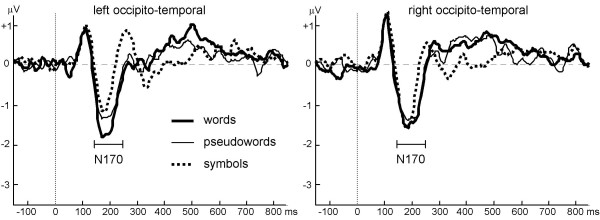
Waveforms at left and right inferior occipito-temporal channels. The N170 is larger for words than for pseudowords and symbols, especially at the left hemisphere channels. Pseudowords have a larger N170 than symbols at both hemispheres, especially during the late part of the N170.